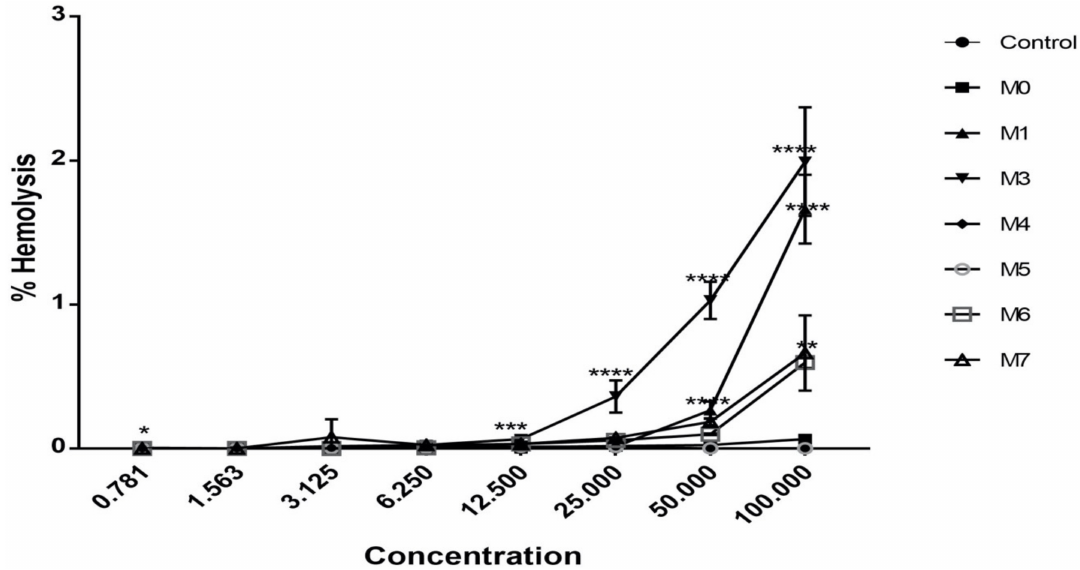
Figure 8. Hemolytic activity of MpVT and its analogs on human erythrocytes. Triton-X 100 was used as a positive control. These concentrations represent the mean values of three independent experiments performed in duplicate. Data are the means ± S.E.M. of one experiment performed in triplicate; * p < 0.3 versus control, ** p < 0.02 versus control, *** p < 0.07 versus control. **** p < 0.0001 versus